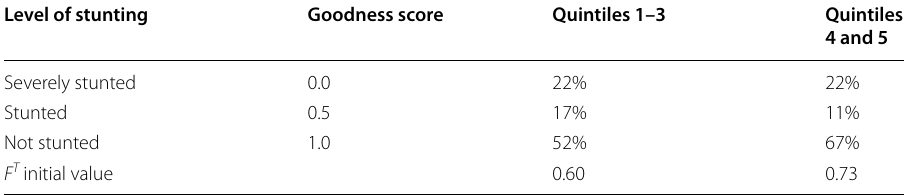
Table 9 Average percentage of children at each level of stunting per socio-economic quintile Level of stunting